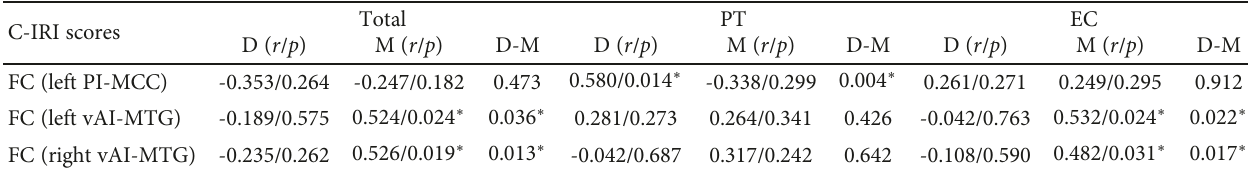
Table 4: Relationship between FC and C-IRI scores.